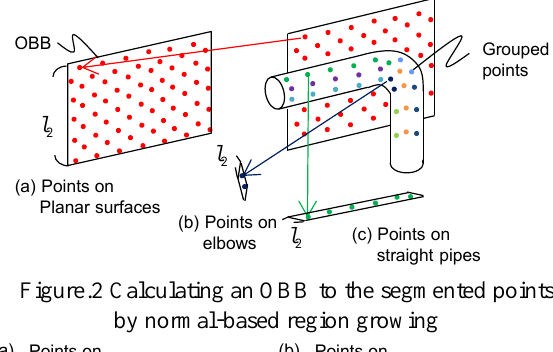
Figure.2 Calculating an OBB to the segmented points by normal-based region growing